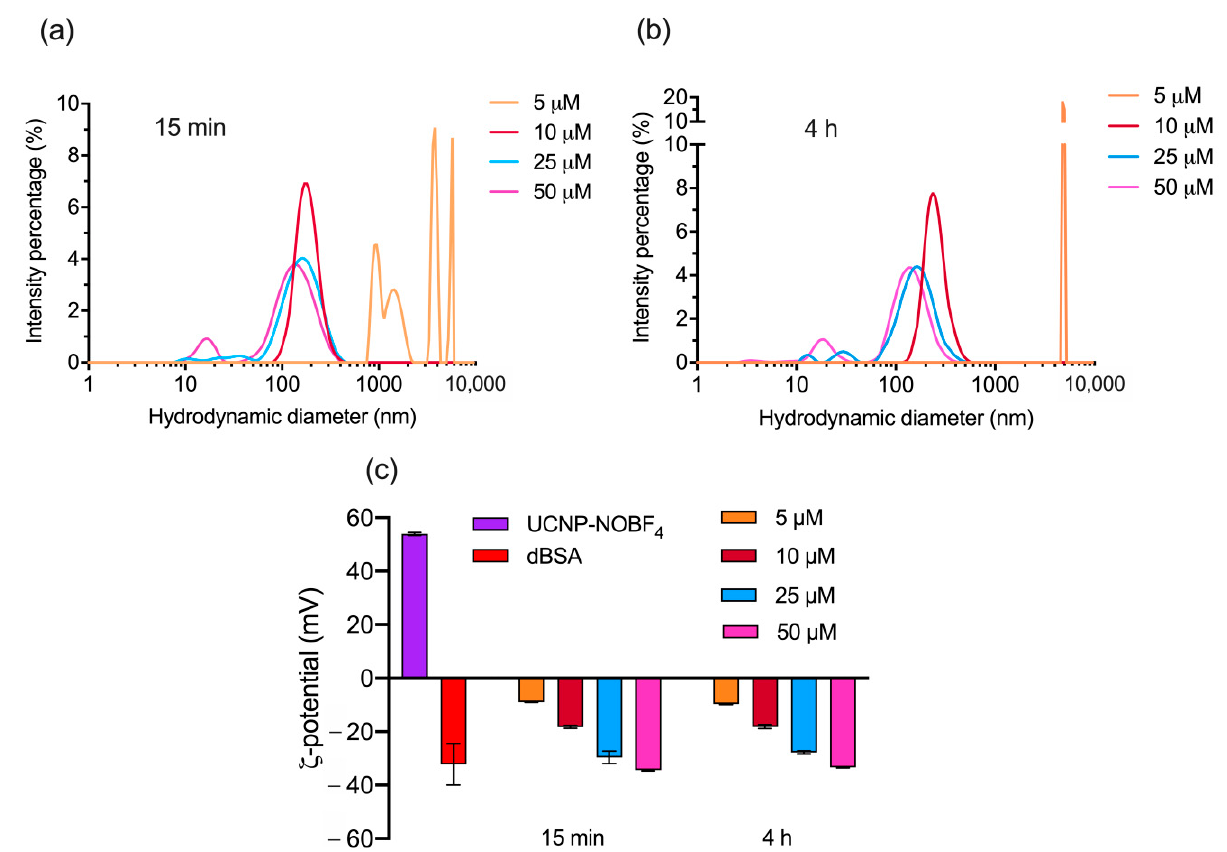
Figure 3. Concentration optimization of dBSA for forming PC on the surface of UCNP-NOBF 4 : ( a , b ) hydrodynamic diameter of dBSA-UCNP-NOBF 4 following the incubation of UCNP-NOBF 4 (0.25 mg/mL) with dBSA at different concentrations (5–50 µ M) at room temperature for 15 min and 4 h, respectively measured by DLS; ( c ) the ζ -potential of UCNP-NOBF 4 , dBSA, and dBSA-UCNP-NOBF 4 recorded by electrophoretic light scattering (ELS). All samples were dispersed in deionized water. Table 2. The hydrodynamic diameter of dBSA-UCNP-NOBF 4 nanocomplexes at different dBSA concentrations (5–50 μ M) measured by DLS in deionized water.